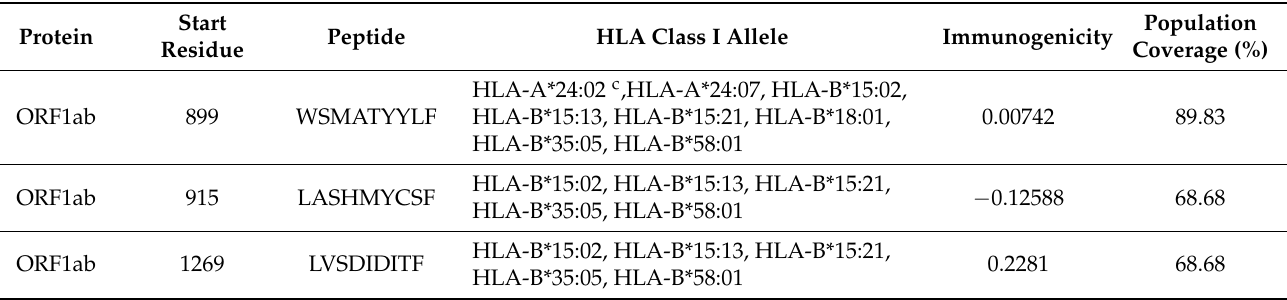
Table 1. Highly promiscuous 9-mer CTL epitopes from five different SARS-CoV-2 proteins (ORF1ab, S, E, M, and N) that bind to at least five different HLA Class I alleles. Immunogenicity, population coverage, and previous report of IEDB finding of each peptide are also